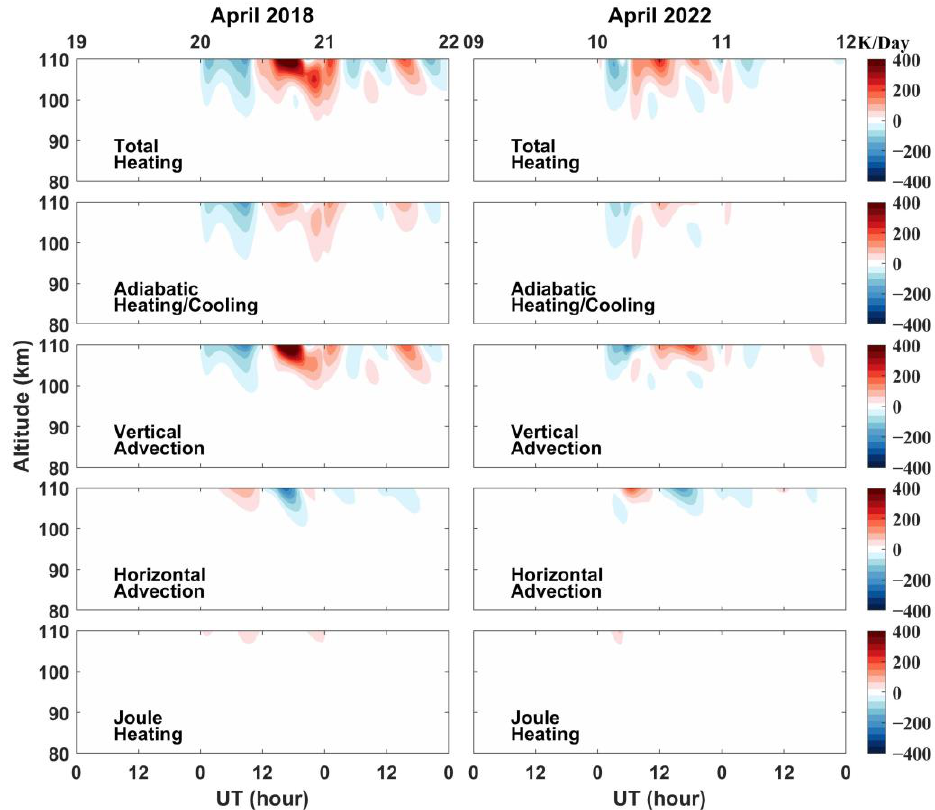
Figure 3. Storm-time differences (rkp − ckp) in total heating terms and major heating terms at the location of (78.75 °S, 60 °E) in the altitude ranges of 80 km to 110 km in the two storms: total heating, adiabatic heating/cooling, vertical heat advection, horizontal heat advection, and Joule heating.